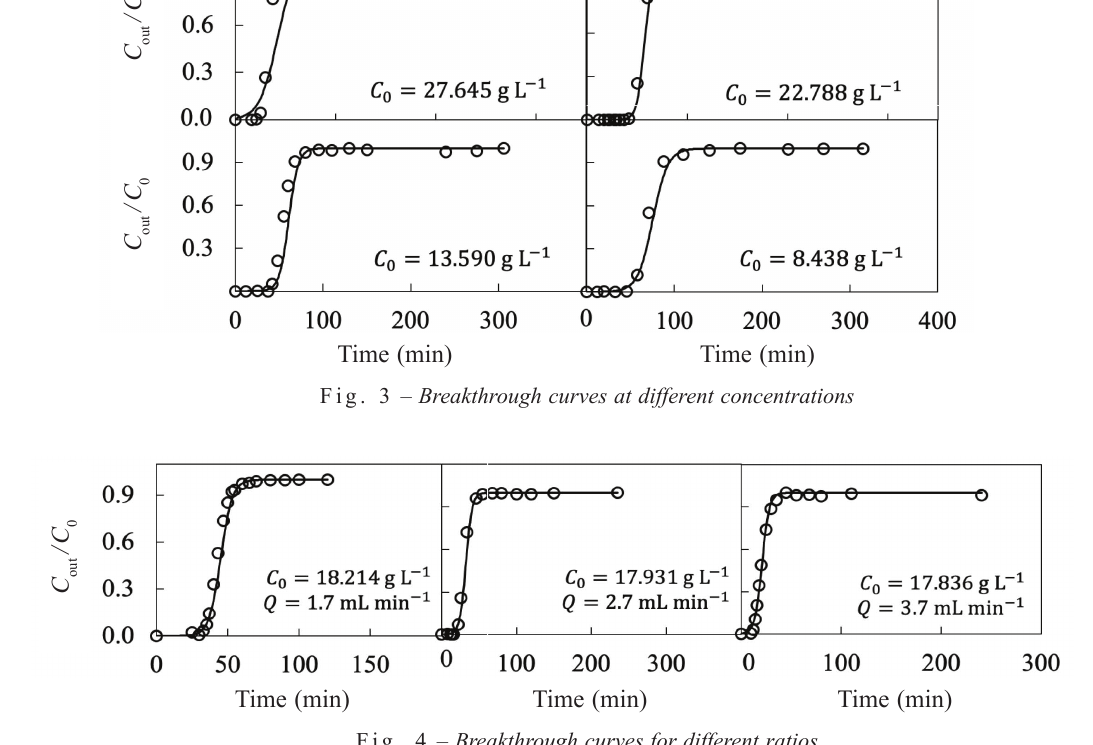
Fig. 4 – Breakthrough curves for different ratios